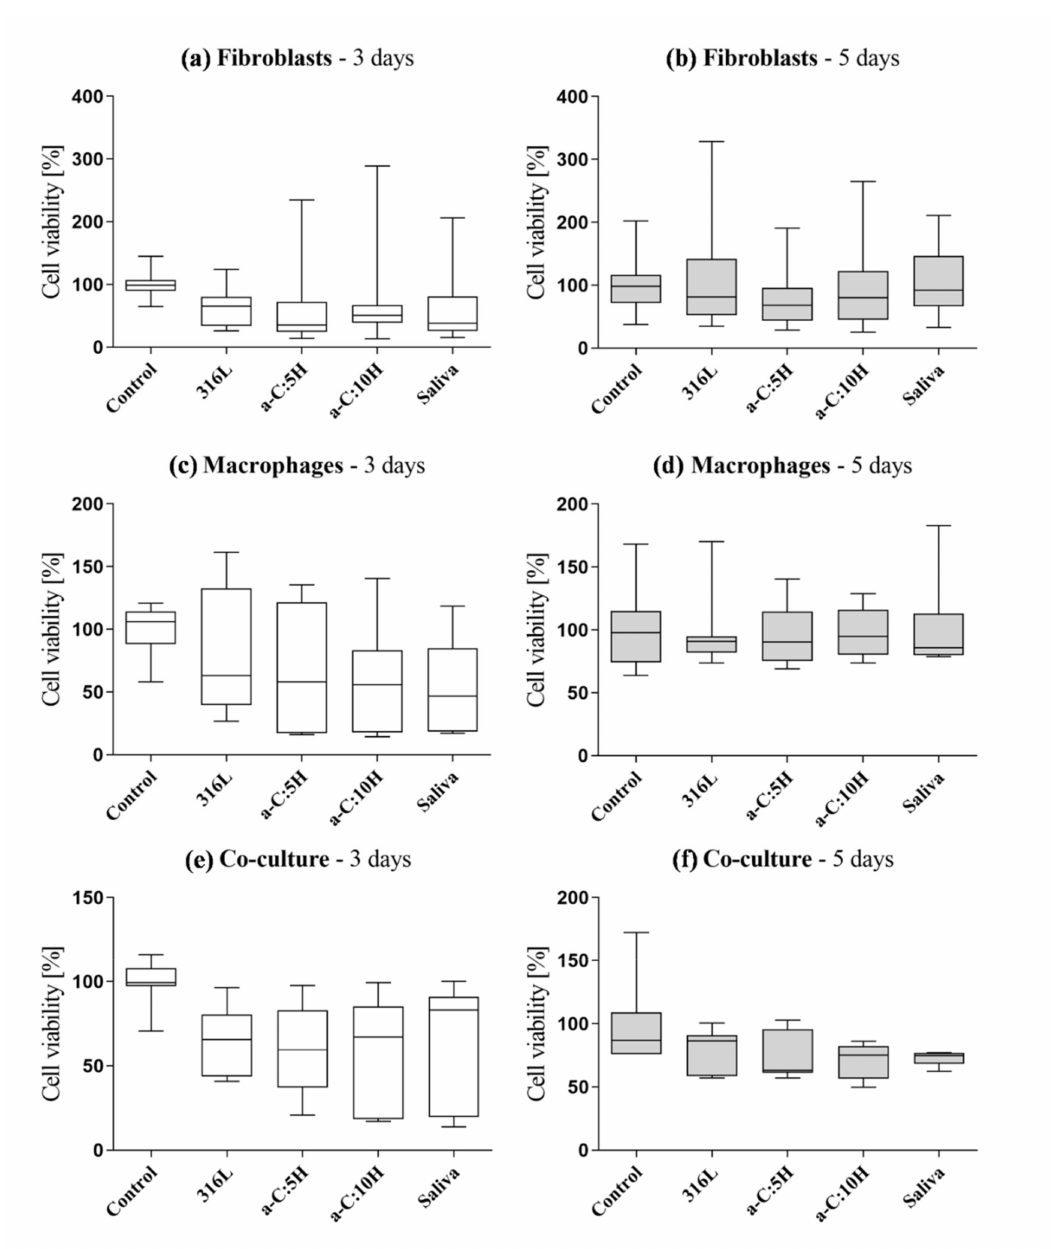
Figure 5. MTT cell viability of ( a , b ) fibroblasts, ( c , d ) macrophages, or ( e , f ) co-culture after incubation with extracts for 3 and 5 days. Legend: 316L–medium conditioned with extracts from SS316L; a-C:5H–medium conditioned with extracts from a-C:5H coatings; a-C:10H–medium conditioned with extracts from a-C:10H coatings; Saliva–medium conditioned with extracts from artificial saliva. (MTT values are expressed in percentage of each mean value of each experimental